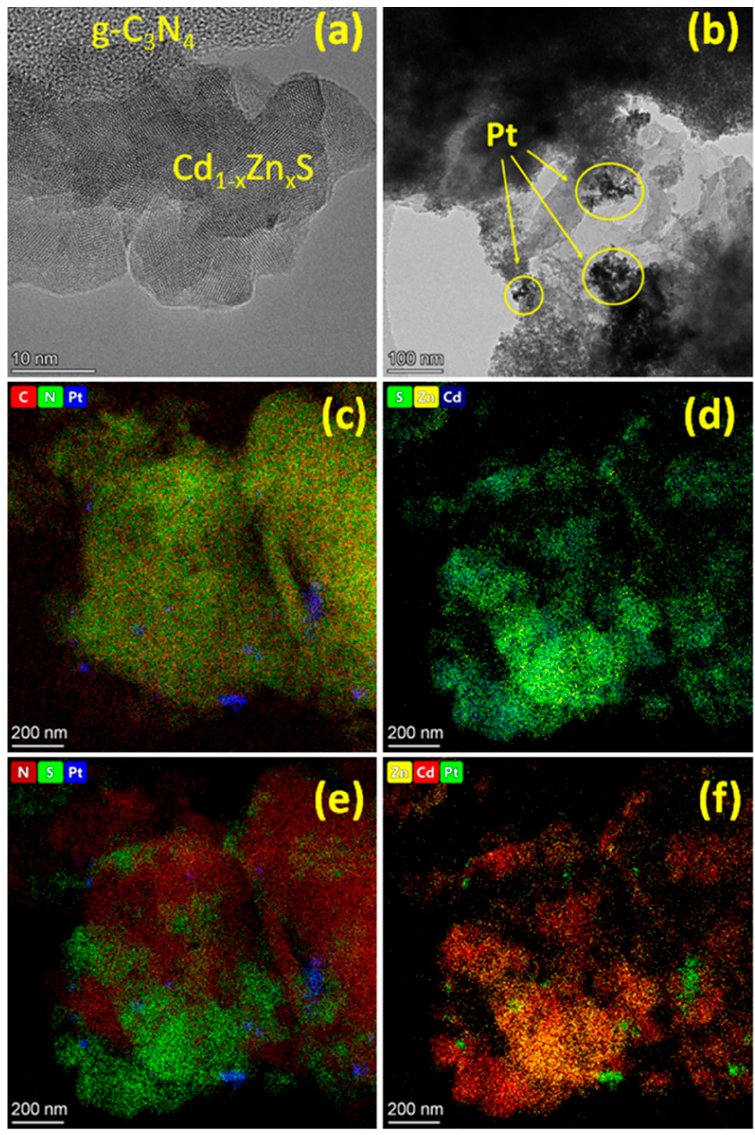
Figure 5. HRTEM images ( a , b ) and elemental mapping of ( c-f ) of the photocatalyst 20Cd0.8/Pt/CN.